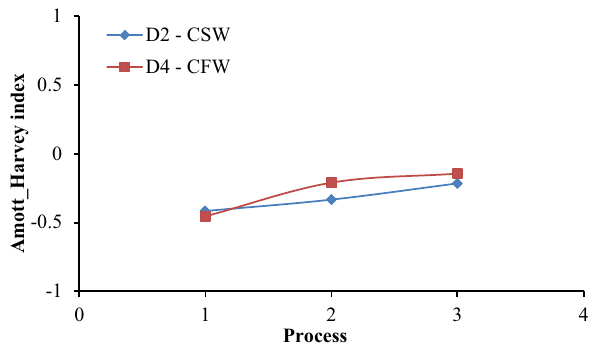
Fig. 12 Effect on Amott–Harvey wettability index for dolomites started with CSW and CFW